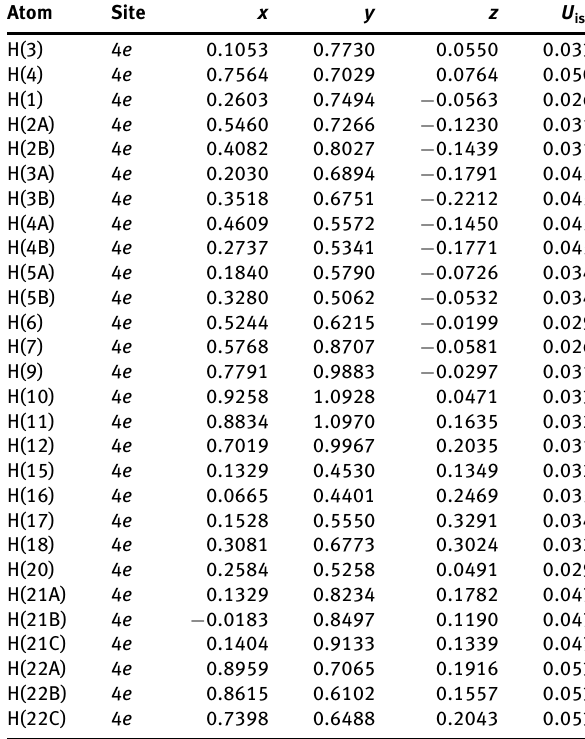
Table 2: Fractional atomic coordinates and isotropic or equivalent isotropic displacement parameters (Å 2